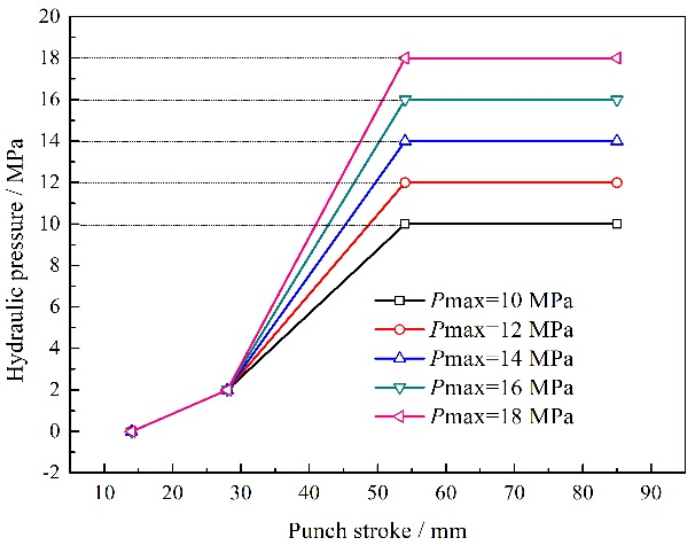
Figure 9. The designed five loading paths of maximum hydraulic pressure.